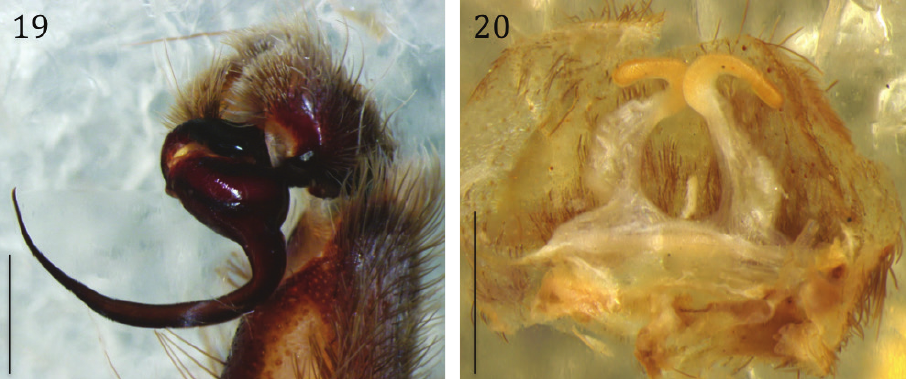
Figures 19, 20. Phlogiellus longipalpus sp. n. 19 holotype ♂ , CUMZ-C2-NA1, left pedipalps, retrolat- eral view 20 paratype ♀ , CUMZ-C4-NA4, spermathecae, dorsal view. Scale bars: 1 mm.